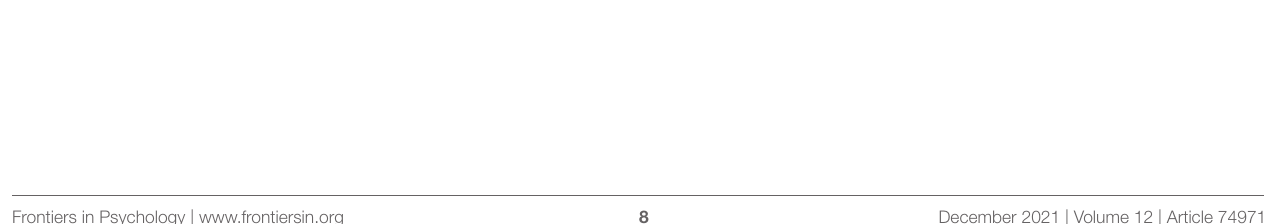
Frontiers in Psychology |